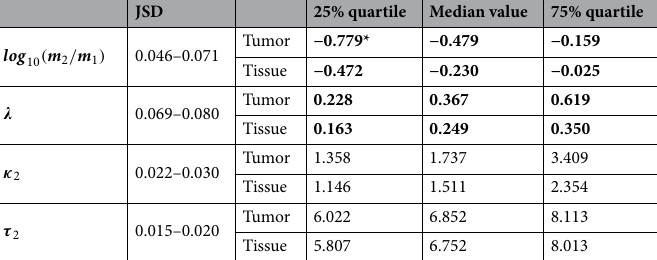
JSD 25% quartile Median value 75%